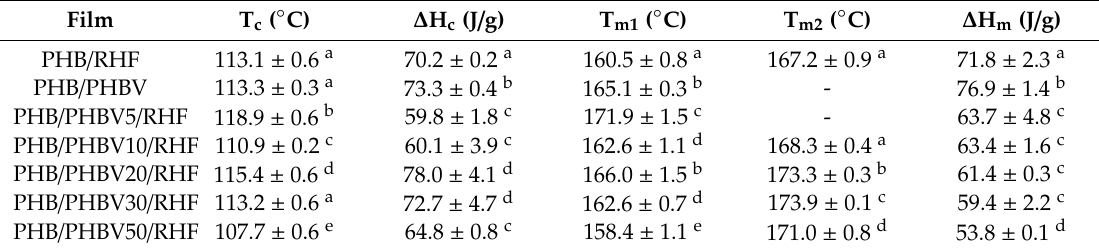
Table 3. Main thermal parameters of the thermo-compressed films made of poly(3-hydroxybutyrate) (PHB), poly(3-hydroxybutyrate- co -3-hydroxyvalerate) (PHBV), and rice husk flour (RHF) in terms of: crystallization temperature (T c ), normalized enthalpy of crystallization ( ∆ H c ), melting temperature (T m ), and normalized melting enthalpy ( ∆ H m ). Film T c ( ◦ C) ∆ H c (J / g) PHB /